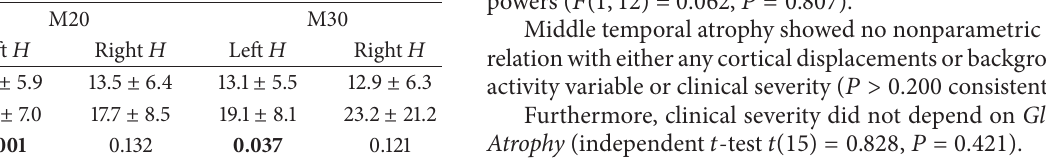
Table 2: M20 and M30 ECD